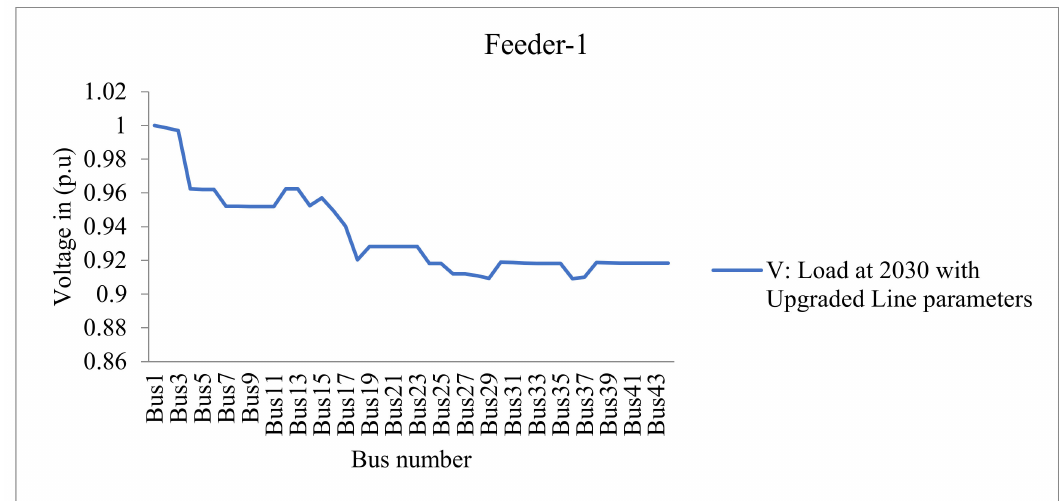
Figure 6. Voltage profiles of Addis north upgraded feeder-1 distribution network.